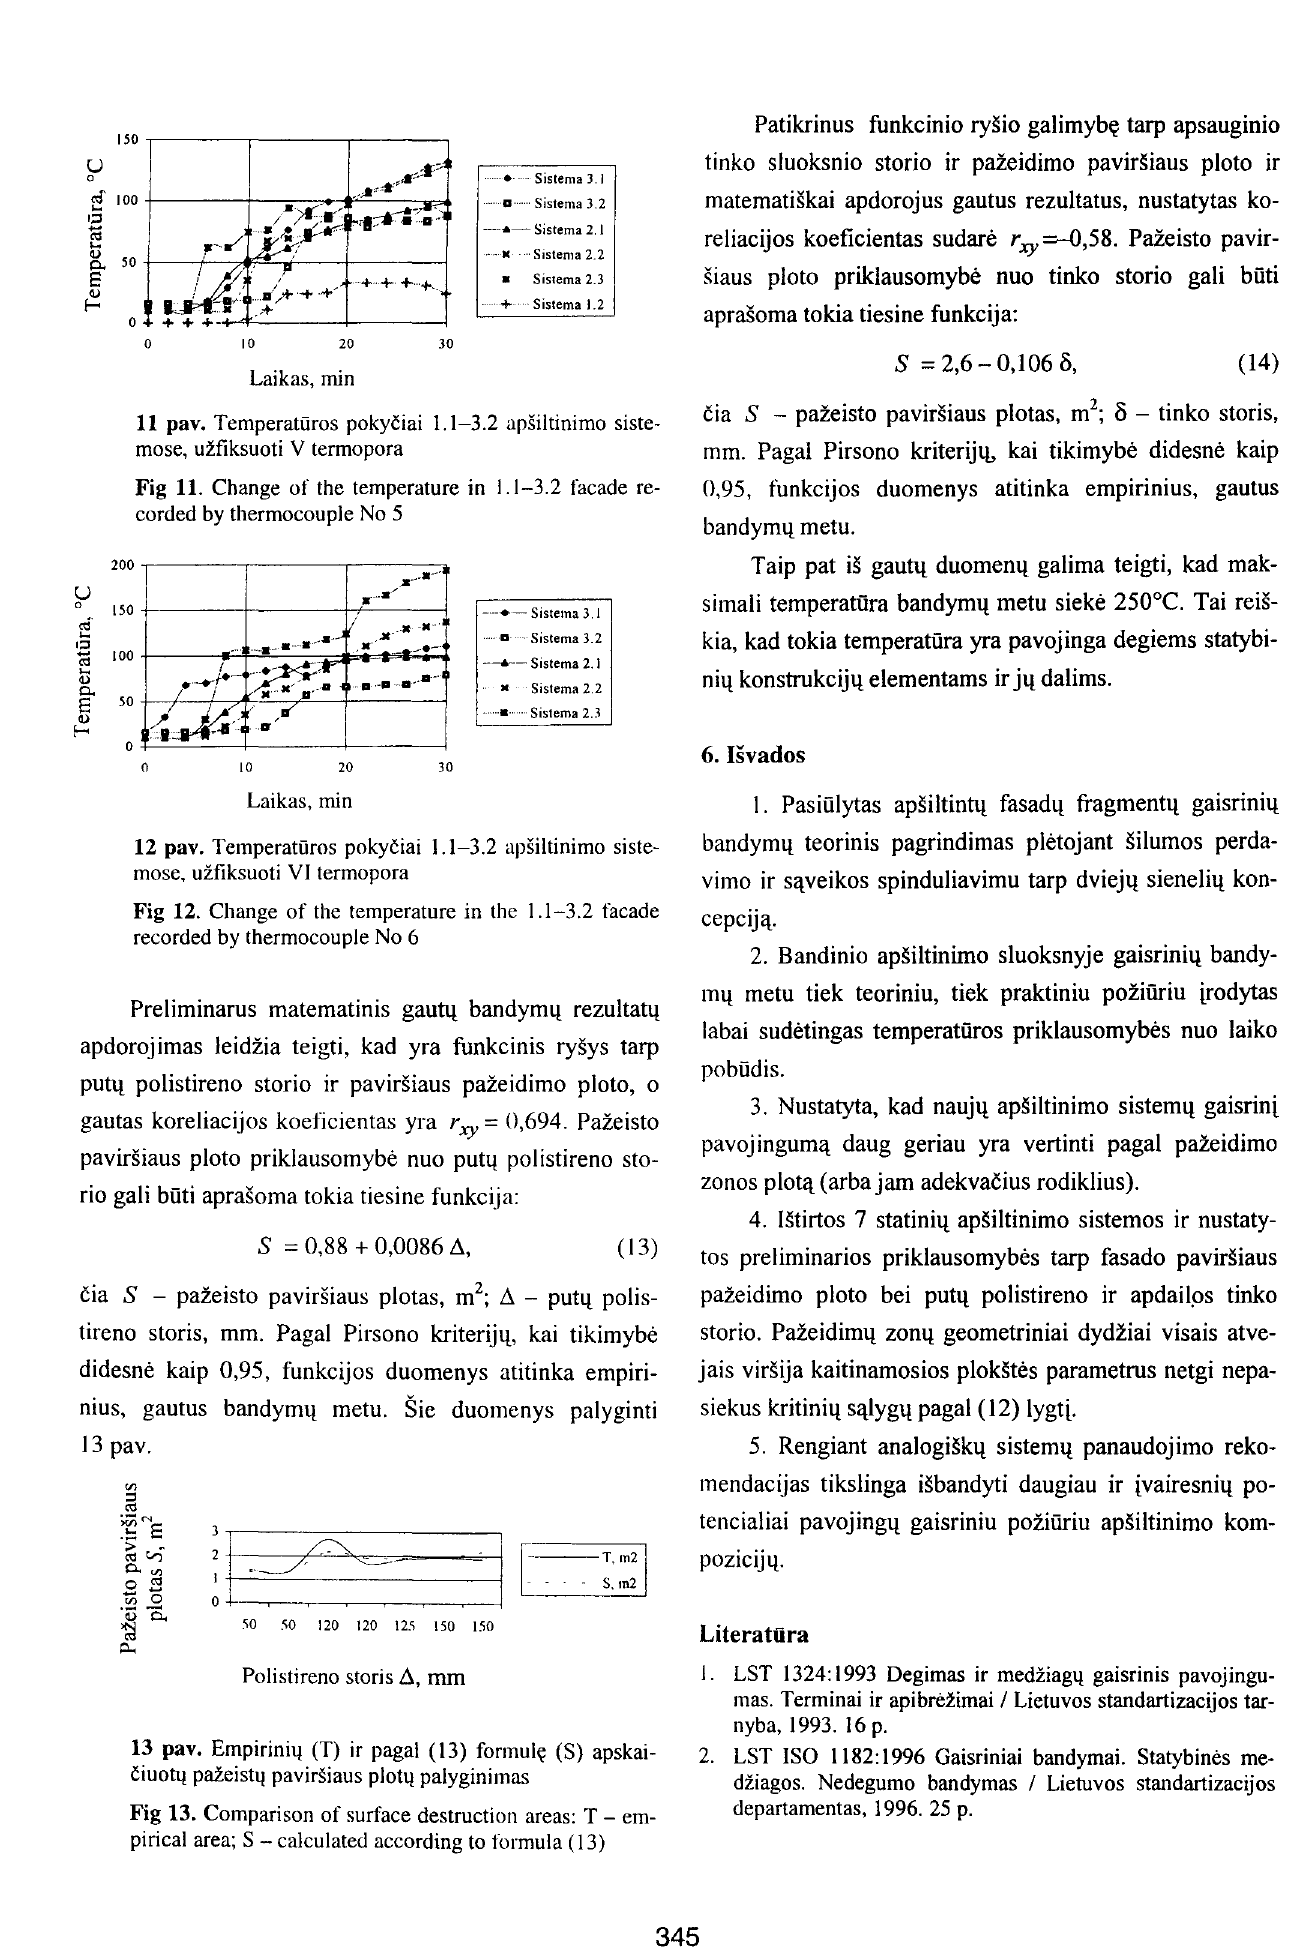
ciuotq paieistq pavirsiaus plotq palyginimas Fig 13. Comparison of surface destruction areas: T- em pirical area; S- calculated according to formula (